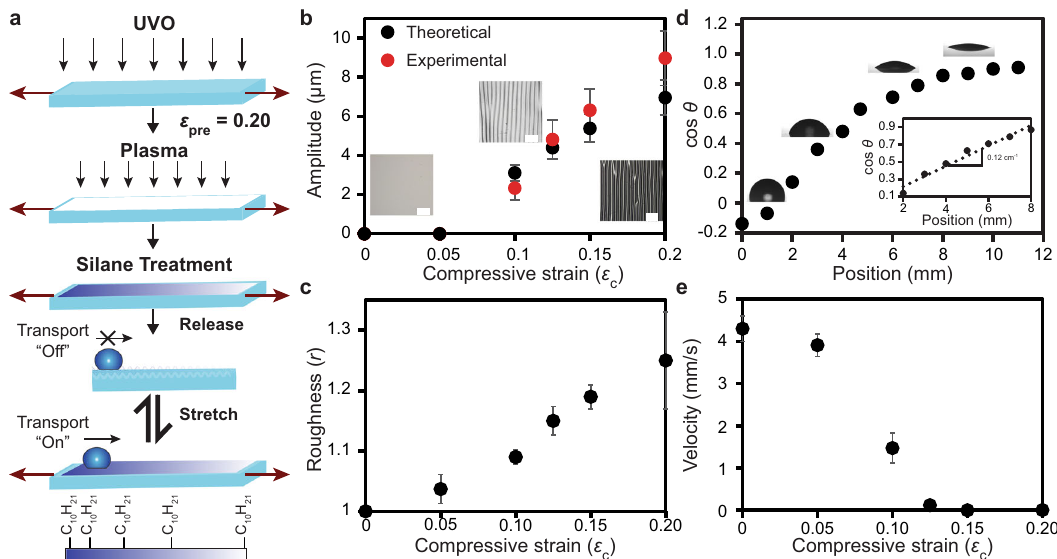
Fig. 1 Fabrication and mechanically controlled droplet transport. a Schematic illustrating the process for fabricating chemical gradients on fi lms with mechanically tunable surface microtextures (wrinkles) and their use in mechano-activated droplet transport. b The theoretical and experimentally measured wrinkle amplitudes. Insets: optical micrographs of the surface topography at ε c = 0, 0.10, and 0.20 respectively, (scale bars = 200 µ m). ( N = 30 for each data point, data reported as (cid:1) x ± s where (cid:1) x is the mean and s is the standard deviation). c Surface roughness of the microtextured gradients at increasing magnitudes of compressive strain ( ε c ). ( N = 5 for each data point, data reported as (cid:1) x ± s where (cid:1) x is the mean and s is the standard deviation). d Variation in the measured contact angle ( θ ) as a function of position for an uncompressed PDMS fi lm. Inset: The contact angle variation for the linear portion of the gradient. e Transport velocity of 3 µ L H 2 O droplets on the microtextured gradients at increasing magnitudes of compressive strain. ( N = 5 for each data point, data reported as (cid:1) x ± s where (cid:1) x is the mean and s is the standard